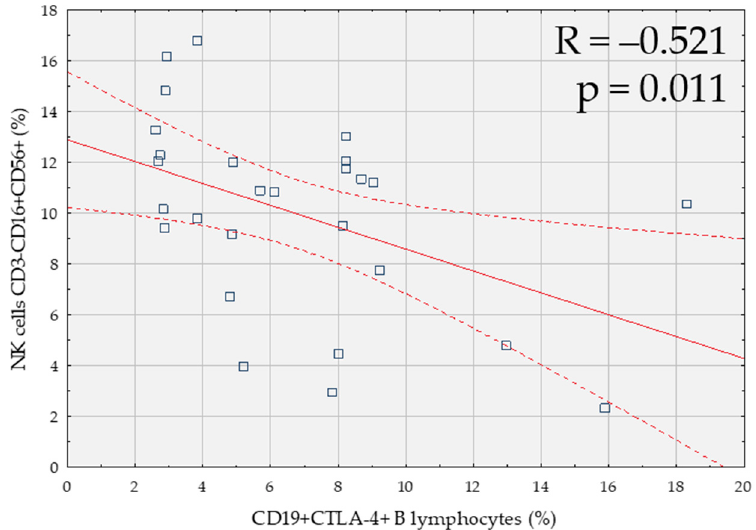
Figure 4. Correlation between the percentage of B lymphocytes expressing CTLA-4 (CD19+CTLA- 4+) and the percentage of NK cells (CD3-CD16+CD56+) in patients with endometriosis and coexist- ing infertility ( n =